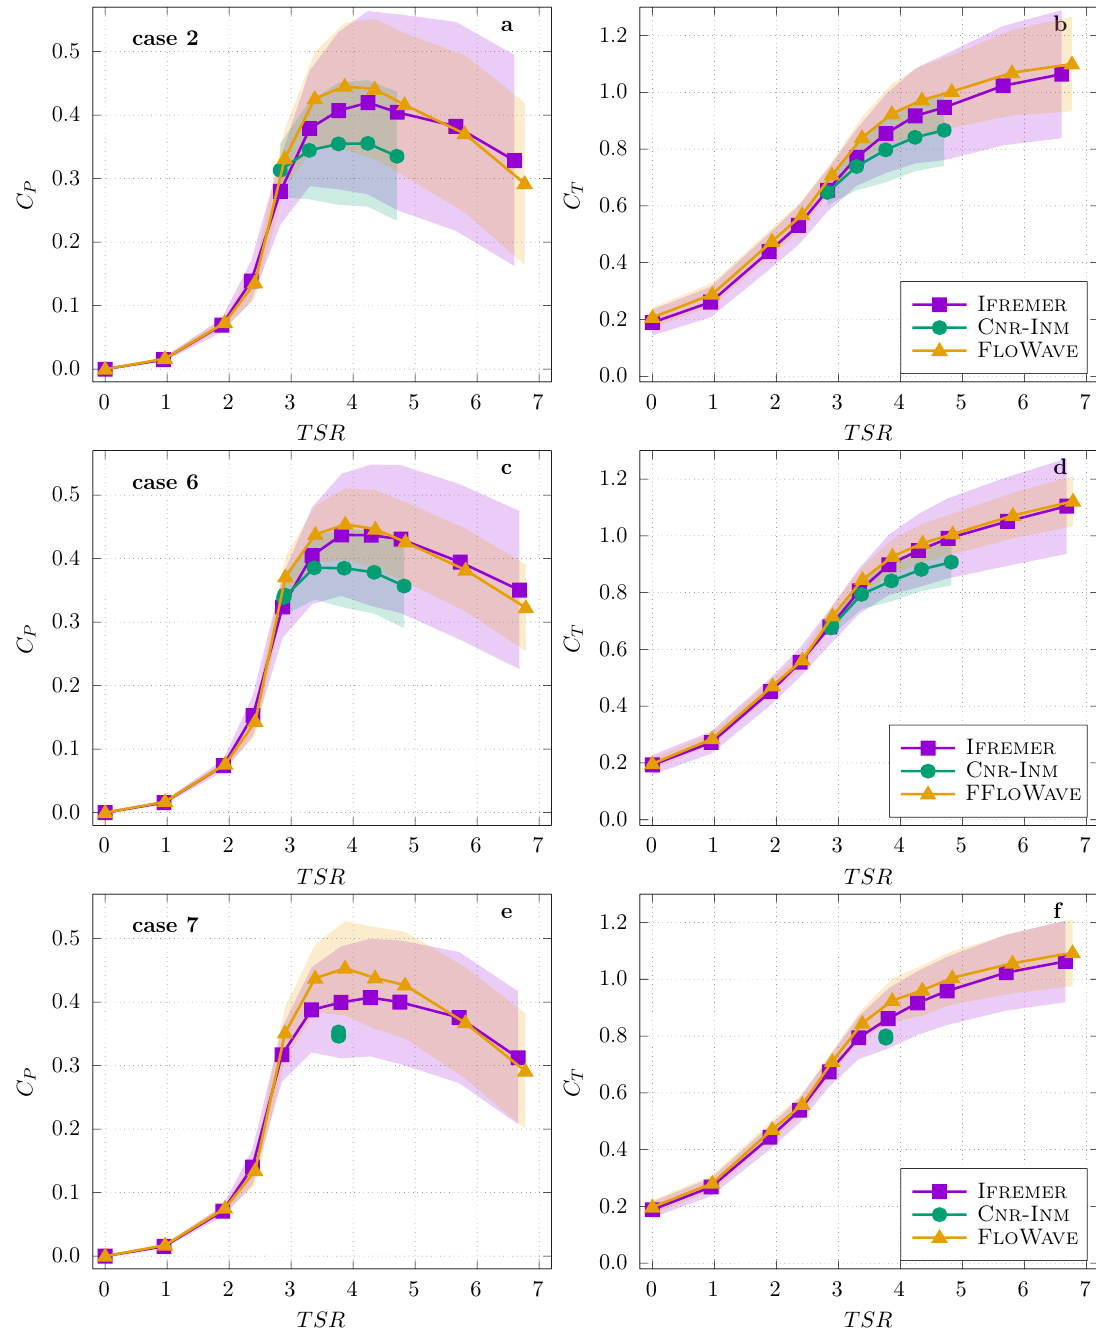
Figure 15. Power ( a , c , e ) and thrust ( b , d , f ) coefficients comparison for wave and current cases: 2 regular wave with 0.8 m/s ( a , b ), 6 regular wave with 1.0 m/s ( c , d ) and 7 irregular wave with 0.8 m/s ( e , f ), versus TSR (see Table 3 for cases